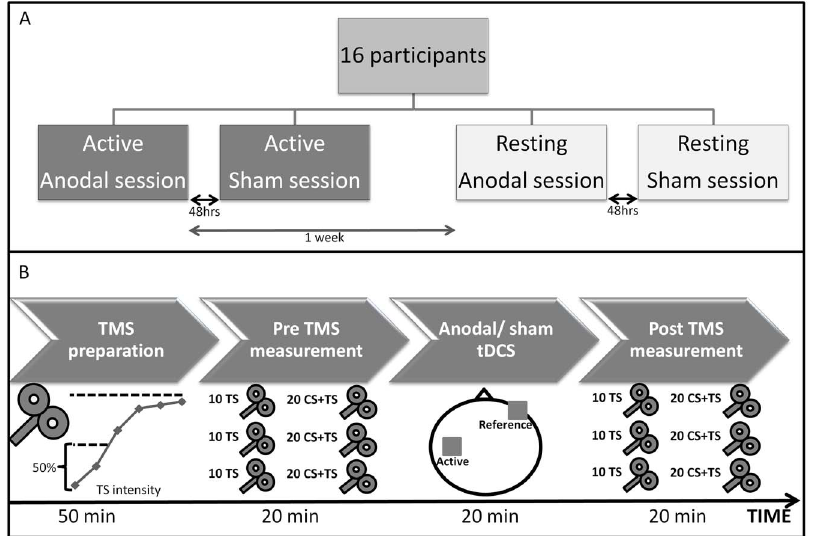
Figure 1. Study protocol. A : Each participant was tested in 4 separate sessions: 2 active sessions (anodal and sham) and 2 resting sessions (anodal and sham). There was at least 1 week break between 2 consecutive anodal sessions and 48 hrs break between other sessions. The order of testing was counterbalanced. B : Test session procedure. An IO-curve was measured to determine the test stimulation (TS) intensity defined as 50% of the maximum MEP amplitude. Pre and post TMS measurement consisted of 3 blocks of 30 TMS pulses. Each block consisted of 10 single pulse (measuring corticomotor excitability) and 20 double pulse (measuring SICI) TMS measurements. Anodal/sham tDCS was applied for 20 min over the left primary motor cortex with 1 mA intensity.